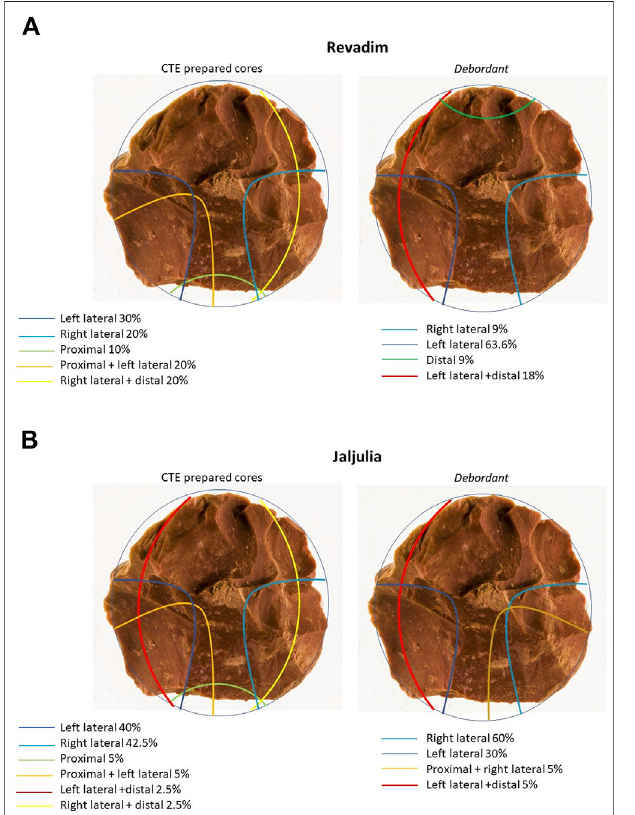
FIGURE 11 | (A,B) Prepared cores fl akes from Revadim. The bulb of percussion is highlighted by a blue line. Jaljulia blanks produced from prepared cores ( n =